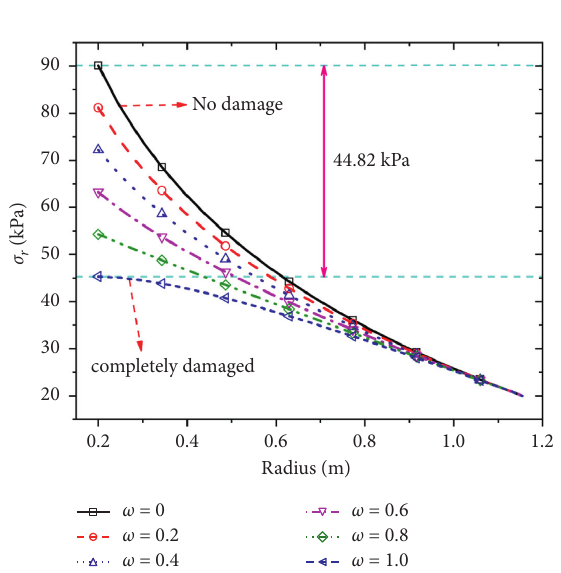
Figure 8: Radial stress distribution in the plastic